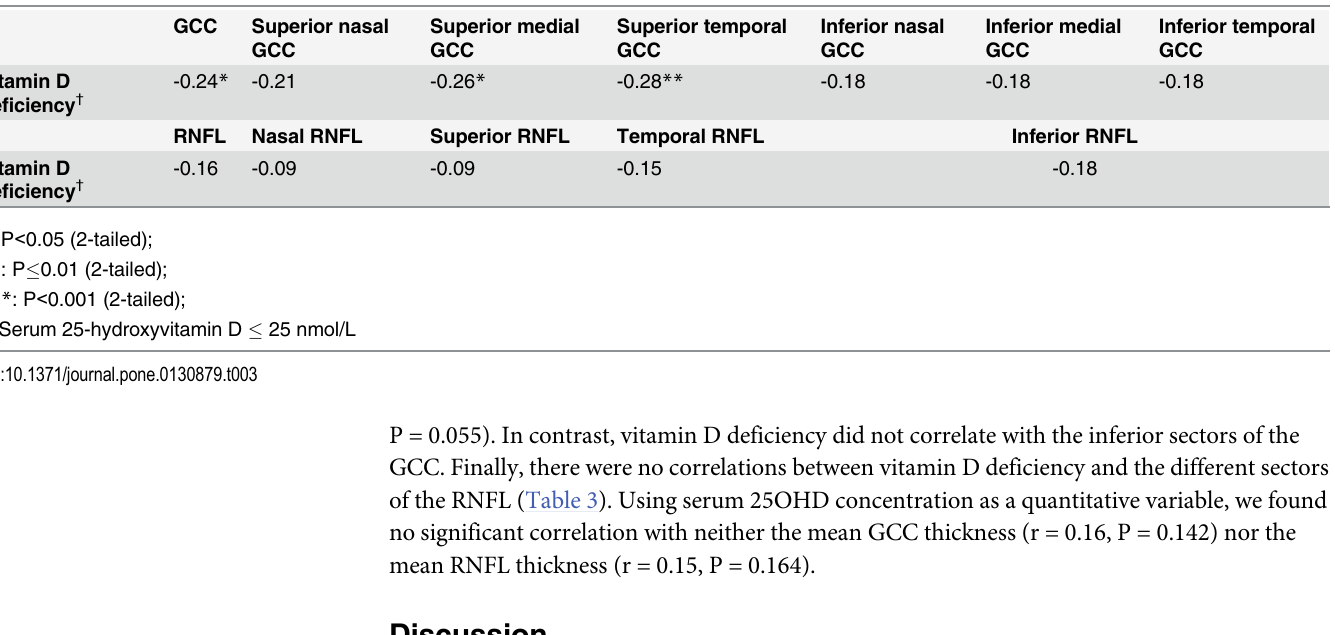
Table 3. Correlation of vitamin D deficiency † with the thickness of the different sectors of the ganglion cell complex (GCC), and with the thickness of the different sectors of the retinal nerve fibre layer